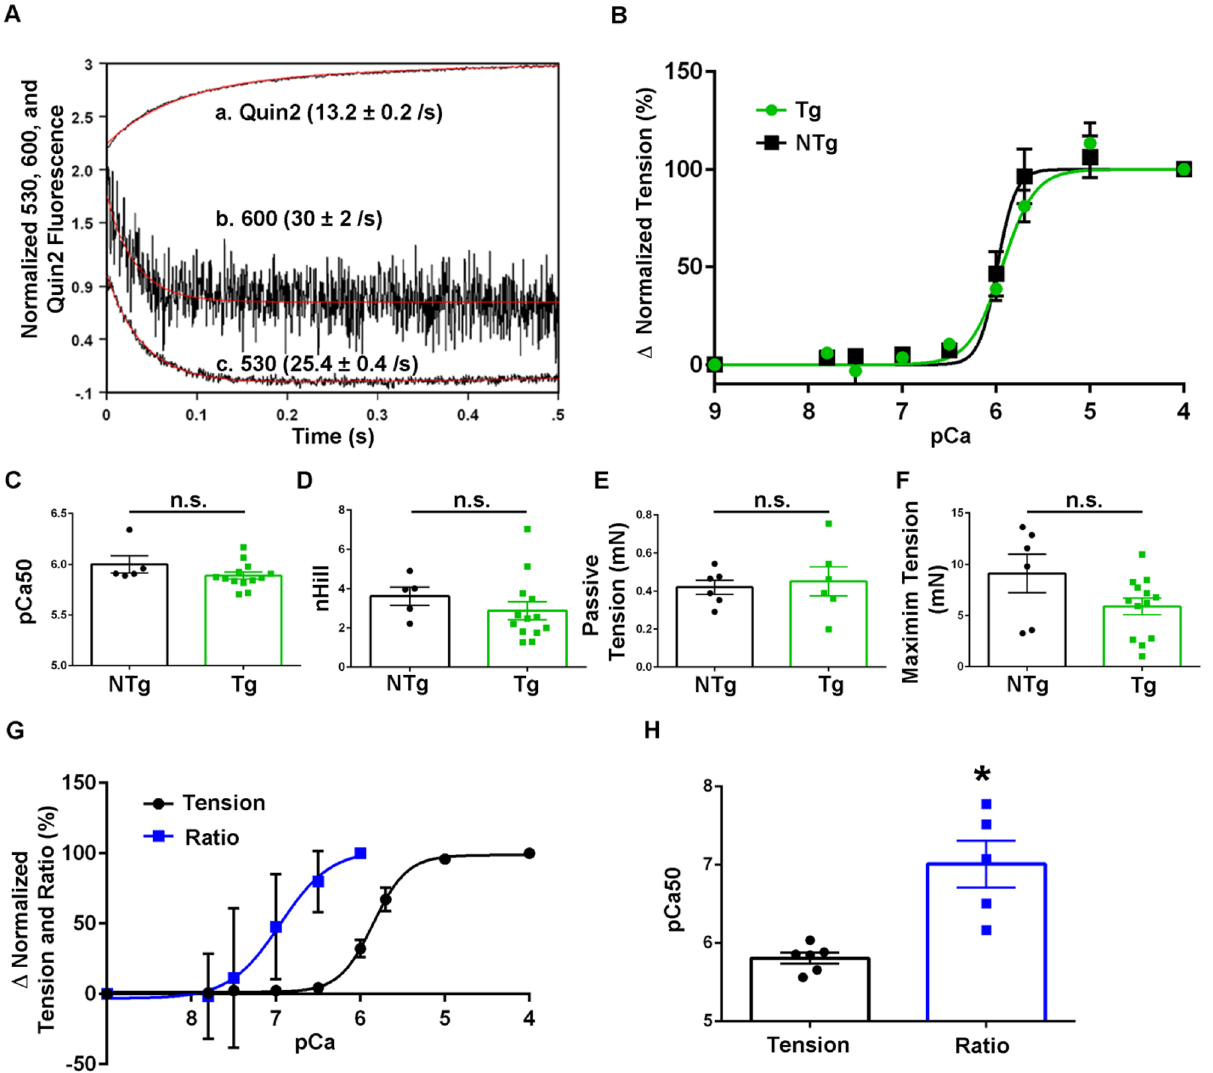
Figure 3. Biochemical and steady-state biophysical analysis of TnC biosensor. ( A ) Calcium dissociation rates of the N-terminal of the control TnC peptide using Quin2 (a) and the N-terminal of the TnC-FRET peptide using 600 nm wavelength for mRuby2 (b) and 530 nm wavelength for Clover (c). ( B ) Relative tension developed as skinned EDL muscle was exposed to solutions of increasing calcium concentrations. Non-transgenic ([NTg, (n = 5 muscles from n = 3 animals)] and transgenic [Tg, (n = 8 muscles from n = 4 animals)] were used. Tension was normalized to the pCa 4.0 value obtained in each preparation. ( C ) Summary statistics of calcium concentration at half-maximal activation (pCa50) for NTg and Tg muscles showed no significant differences. ( D ) Summary statistics of the Hill coefficient value (nHill) for NTg and Tg muscles showed no significant differences. ( E ) Summary statistics of passive tension measurements for NTg and Tg muscles showed no significant differences. ( F ) Summary statistics of max relative tension measurements for NTg and Tg muscles showed no significant differences. ( G ) Combined graph of relative tension and fluorescence ratio changes as skinned EDL muscle exposed to solutions of increasing calcium concentration. Tension was normalized to the pCa 4.0 value obtained in each preparation (n = 6 muscle halves from n = 2 animals) and ratio fluorescence was normalized to the pCa 6.0 value obtained in each preparation (n = 5 muscle halves from n = 2 animals). ( H ) Summary statistics of calcium concentration at half-maximal activation (pCa50) for relative tension and FRET ratio fluorescence showed a significant difference in the pCa50 values. (P < 0.05). Mean ± S.E.M. data are